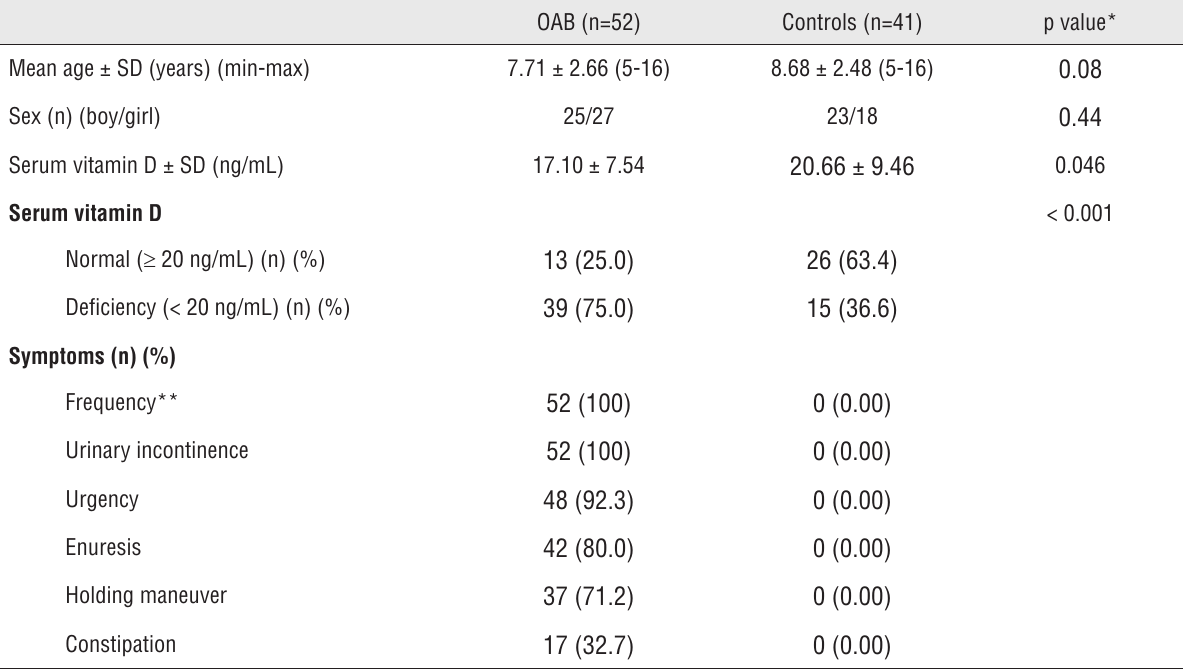
Table 1 - Demographic and clinical characteristics of the study